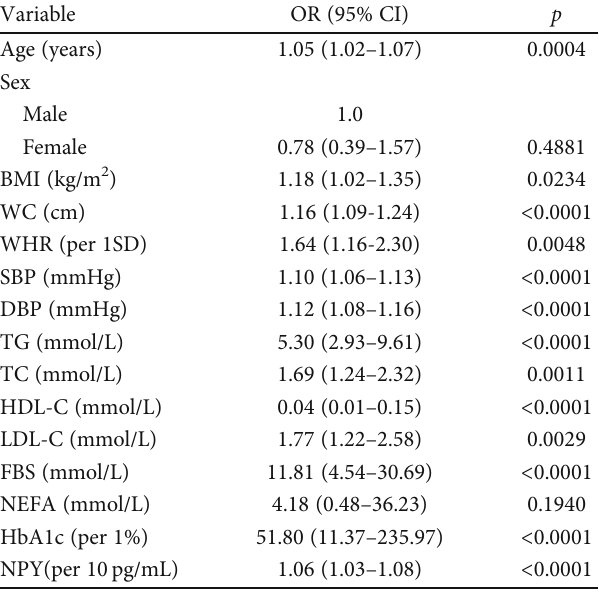
Table 2: Univariate analysis of variables of the participants with